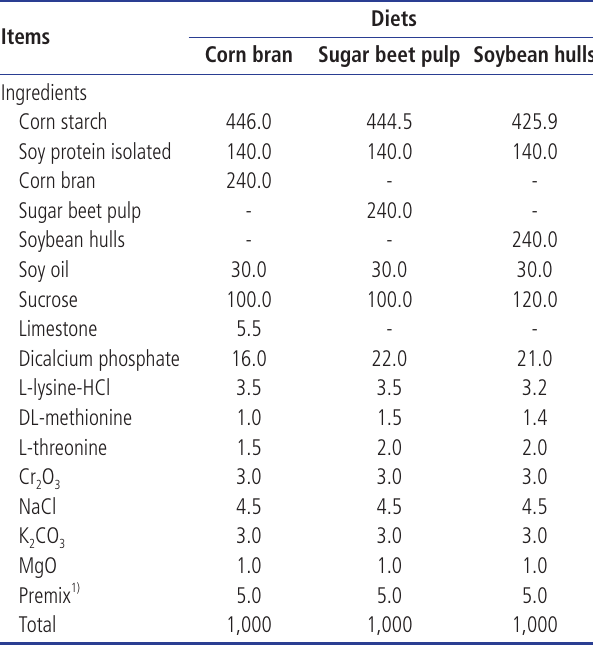
Table 3. The analyzed chemical compositions of the experimental diets (g/kg, as-is basis) 1) Items